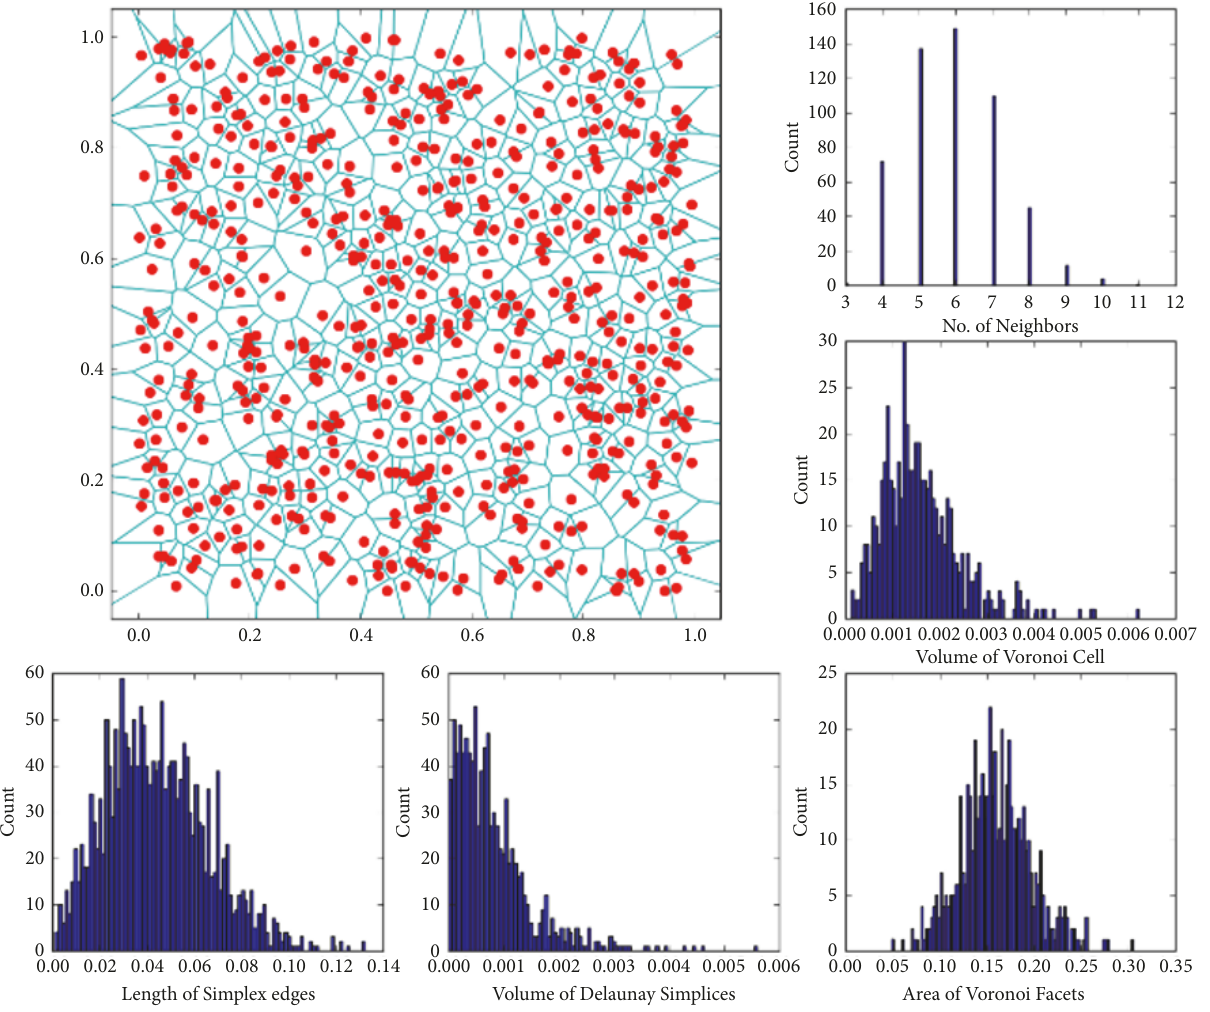
Figure 6: The distributions of the five metrics (from top to bottom, right to left): number of neighbors, volume of Voronoi cells, area of Voronoi facets, volume of Delaunay simplices, and length of simplex edges for randomly distributed particles in a 2-dimensional